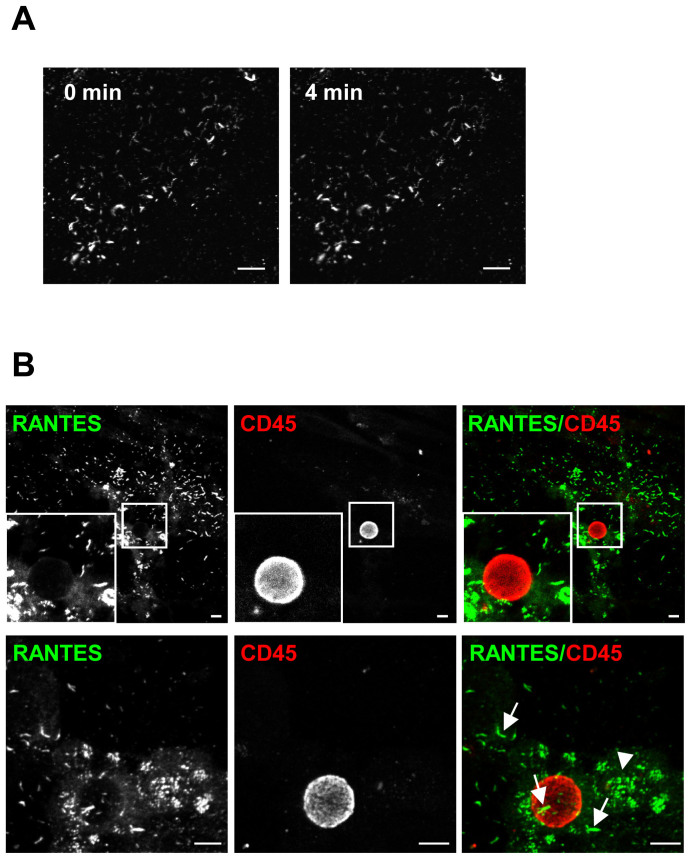
RANTES filaments are present after exposure to shear stress.(A) HUVECs were electroporated with DNA encoding RANTES, cultivated on cover
slips before stimulation with TNFα + IFNγ for 30 h. RANTES
was labeled with an anti-RANTES antibody (clone 21418), and the cover slips
were mounted in a laminar flow chamber. The flow rate was adjusted to mimic
vessel wall shear stress of 1 dyne/cm2. The images
were acquired by confocal microscopy before (left image, 0 min) and
after 4 min with exposure to flow forces (right image, 4 min).
(B) HUVECs were treated as described in (A) except that they were not
labeled with anti-RANTES antibody before exposure to flow. Human peripheral
blood mononuclear cells were labeled with an anti-CD45 antibody, resuspended
in medium and applied by a pump to the flow chamber
(1 dyne/cm2). After 10 min, the cells were
labeled with a rabbit anti-RANTES antibody. Images were acquired by
sequential scanning confocal microscopy. Arrows and arrow heads indicate
RANTES filaments and RANTES positive platelets, respectively. Original
magnification in all panels, × 100. Scale bars, 10 μm.